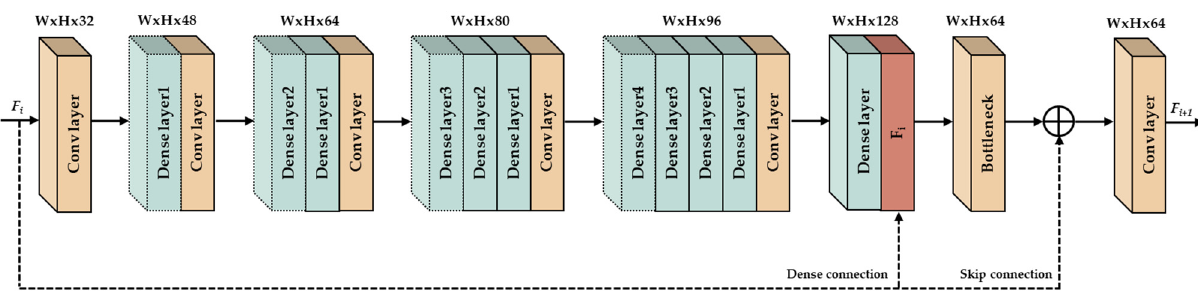
+ indicates the element-wise sum.